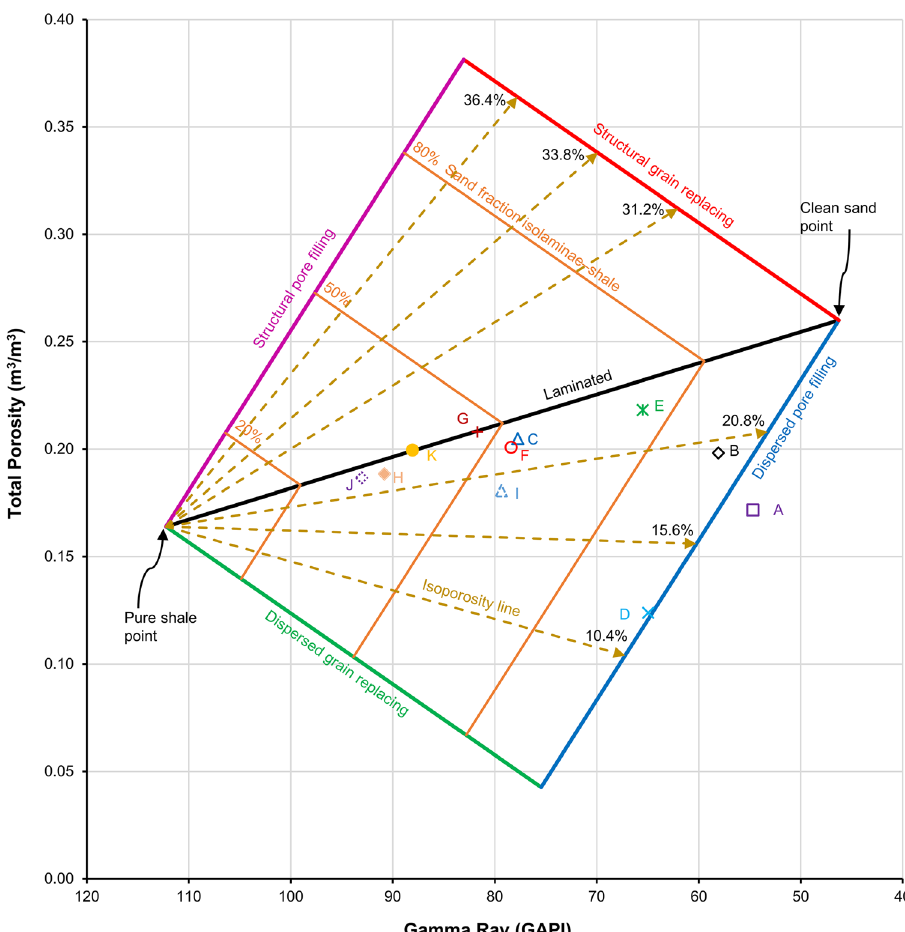
Fig. 6 Thomas–Stieber cross- plot of gamma ray and total porosity using zones mean property [clean sand point is (46.274, 0.26) and pure shale point is (112.243, 0.164)]. The data points (markers) with labels from A to K alongside them represent the zones. This figure is a geometrical solution of the Thomas–Stieber method for laminated sands and shales with sands containing dispersed and/or structural shale which is a base case in this interpreta- tion. The bottom vertex of the lower triangle is the dispersed shale endpoint where the clean sand pore is filled with dispersed shale and top vertex of the upper triangle is the structural shale endpoint where the grain of the original sand is completely replaced with